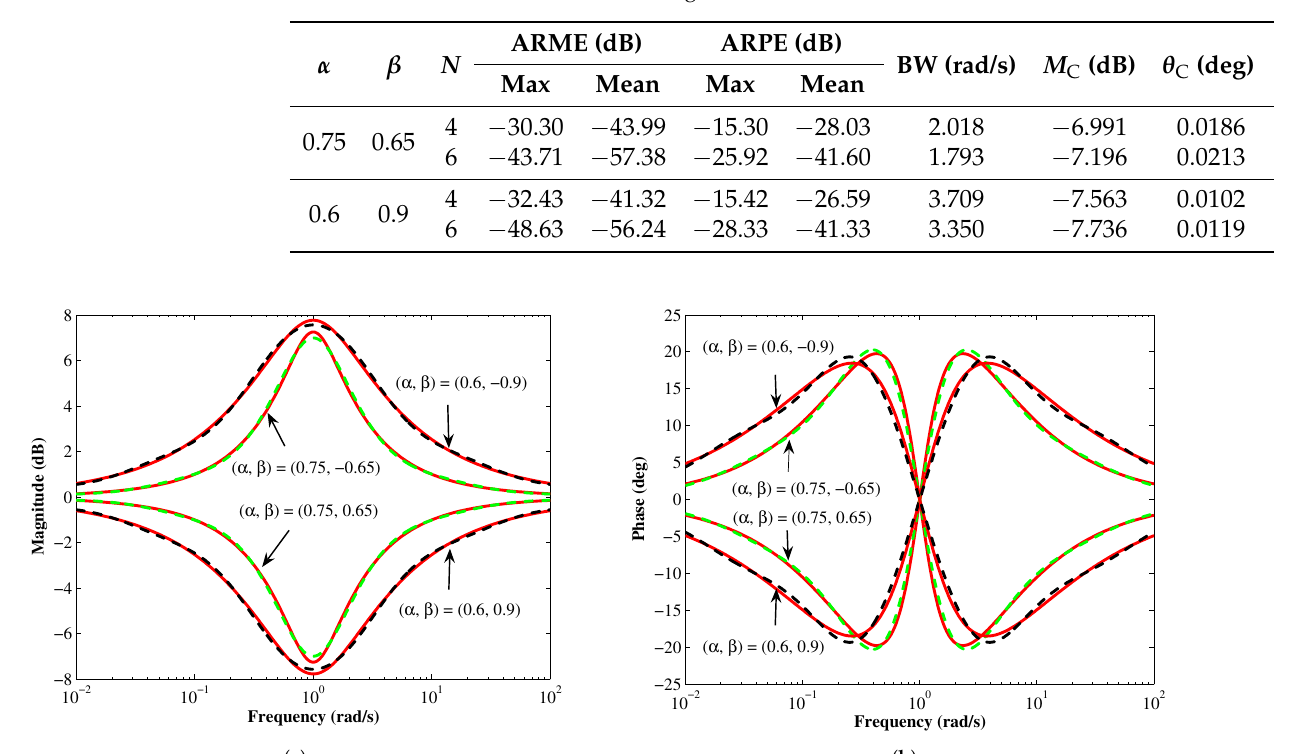
Table 9. Performance indices of the designed FBSFs for different values of N .